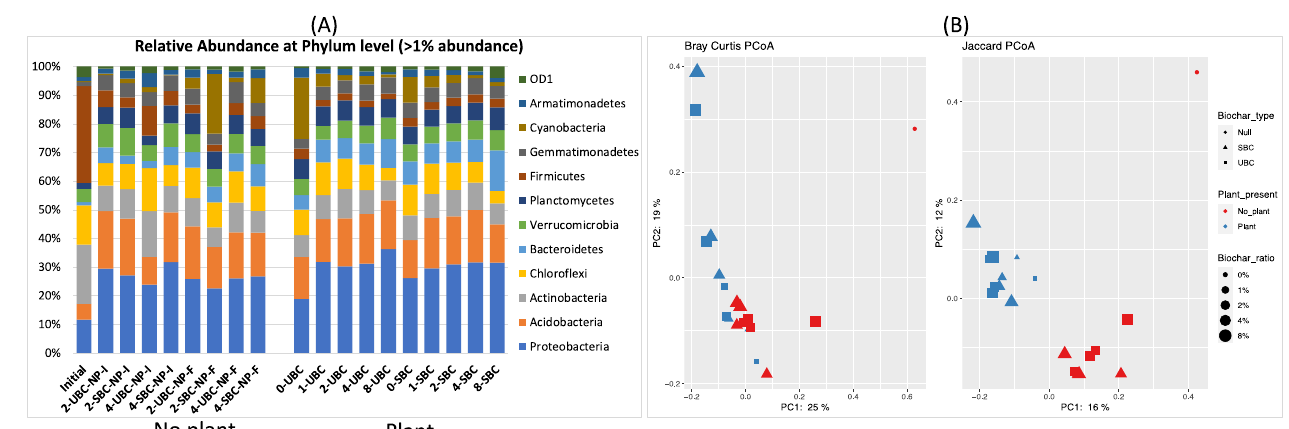
Figure 5. Microbial community composition. Relative abundance of major taxa at phylum level ( A ). Principal coordinate analysis of the microbial community at OUT level ( B ). (Abbreviations: NP; No plant, I; Initial, F; Final).